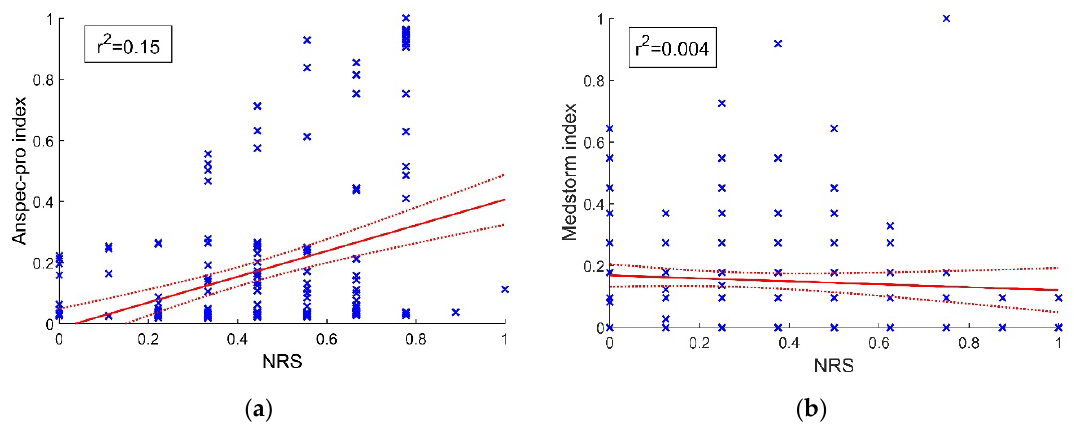
Figure 4. Linear data fitting and confidence bounds: ( a ) positive linear relationship between Anspec-pro index and numeric rating scale (NRS) score; ( b ) non-significant linear relationship between Medstorm index and NRS score. The presented data is normalized. NRS—Numerical Rating Scale.